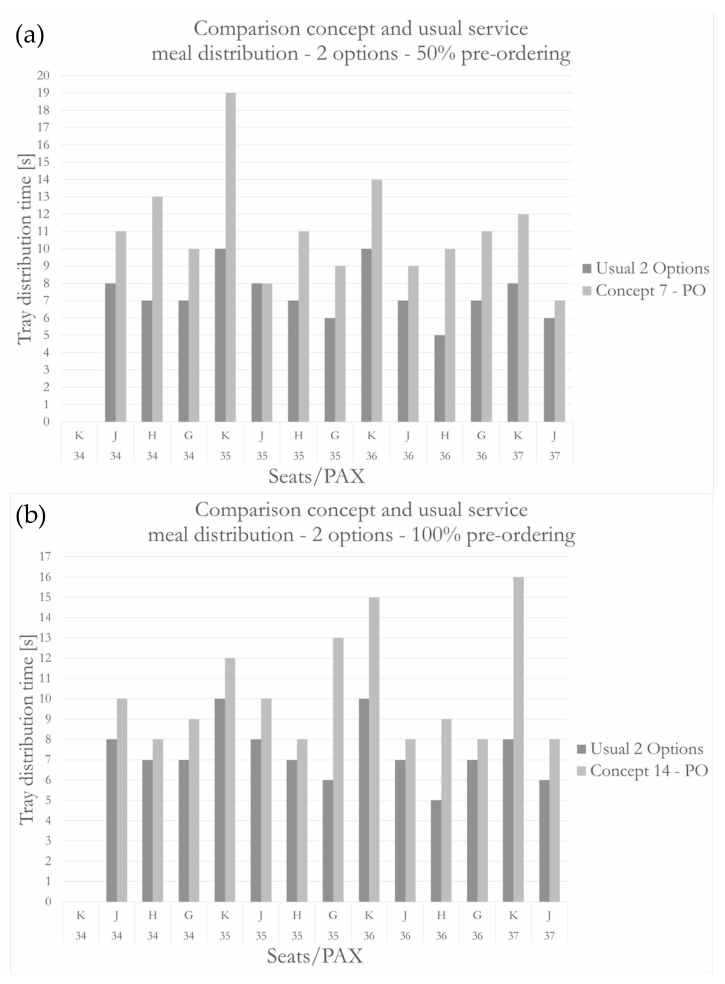
Figure 26. Meal service distribution with ( a ) 50% and ( b ) 100%